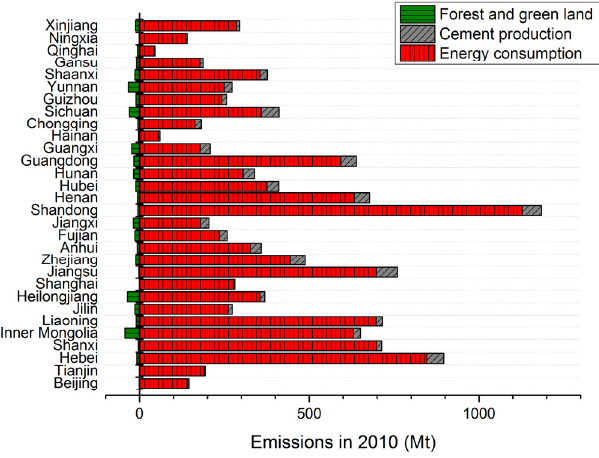
Figure 4. Three aspects of provincial CO 2